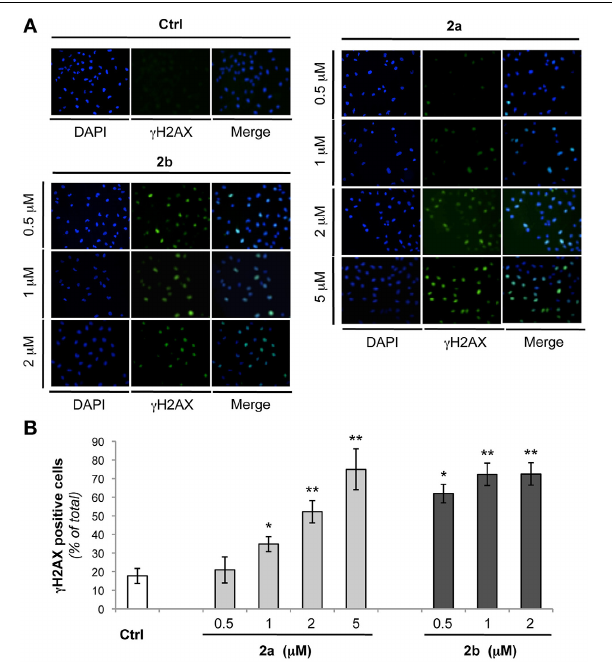
2a and 2b. Transformed BJ-EHLT fibroblasts were grown for 24h in absence ( − ) or in presence of the indicated concentrations of compound 2a or 2b . DNA damage response was evaluated by immunofluorescence (IF) analysis by using an anti- γ H2AX antibody (green) and DAPI (blue) was used to mark nuclei. (A) Representative images of IF analysis. Images were acquired by using a Leica Deconvolution microscope (magnification 20 × ). (B) Quantification of γ H2AX-positive BJ-EHLT fibroblasto from (A) . Histograms show the mean values ± SD of at least three independent experiments. p -values were calculated using the student t -test ( ∗ p < 0 . 05; ∗∗ p < 0 .